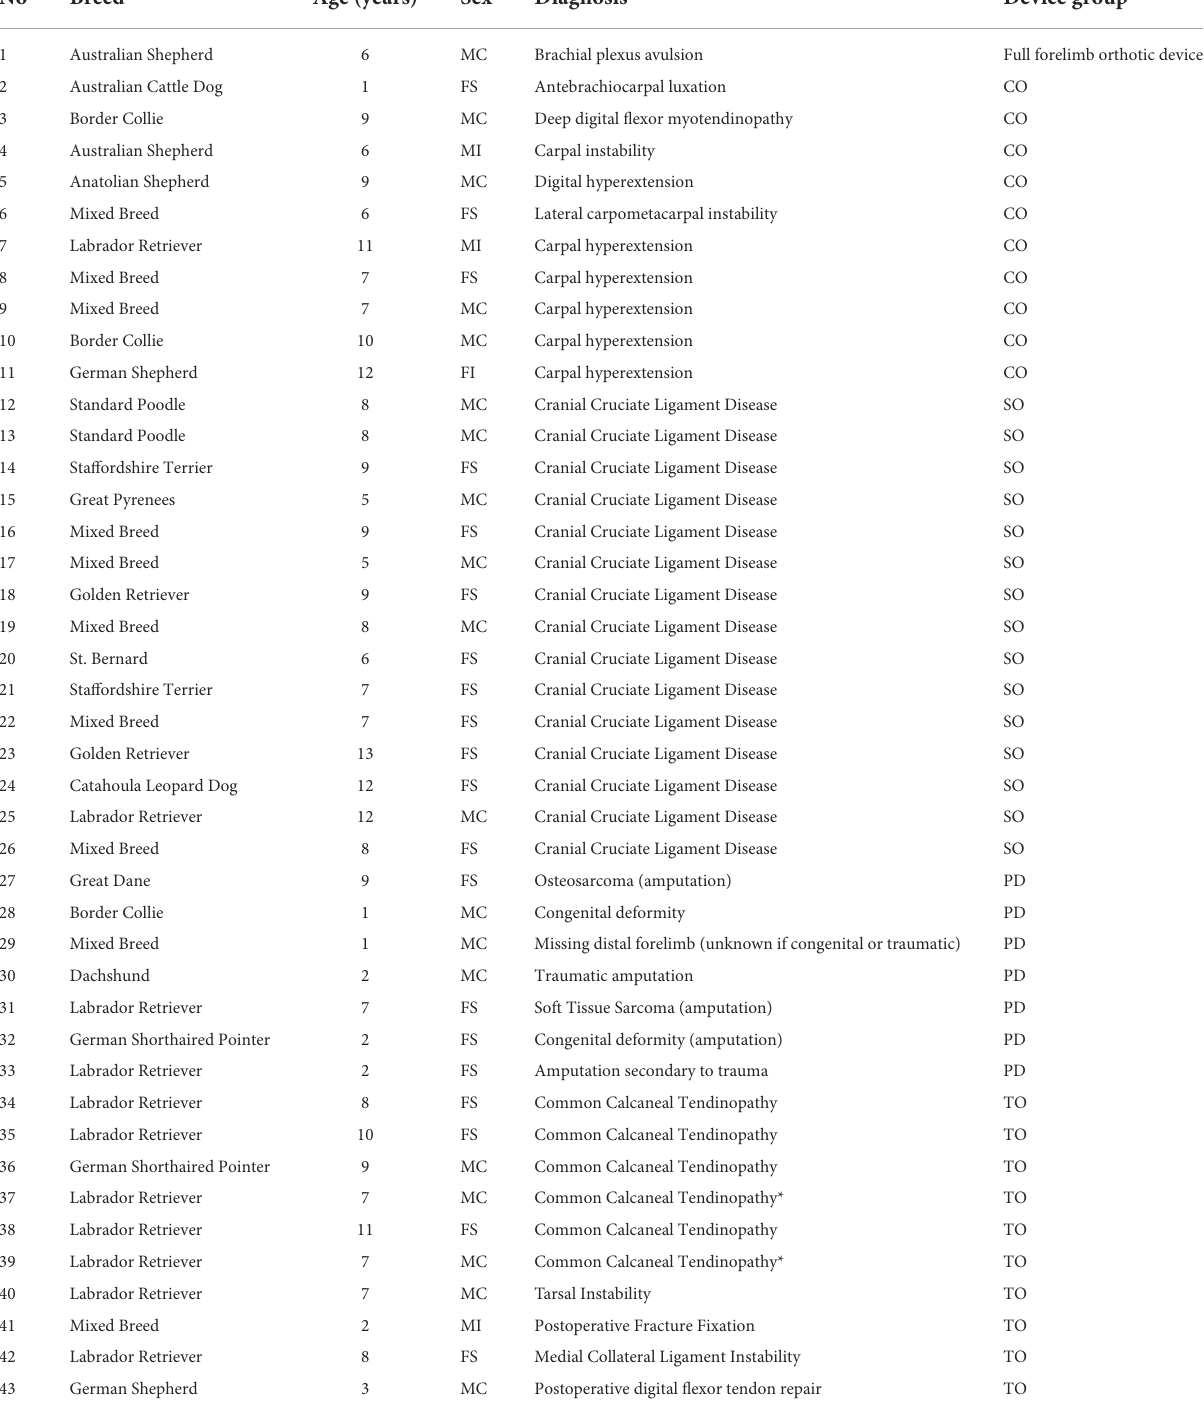
TABLE 2 Patient signalment, diagnosis, and device